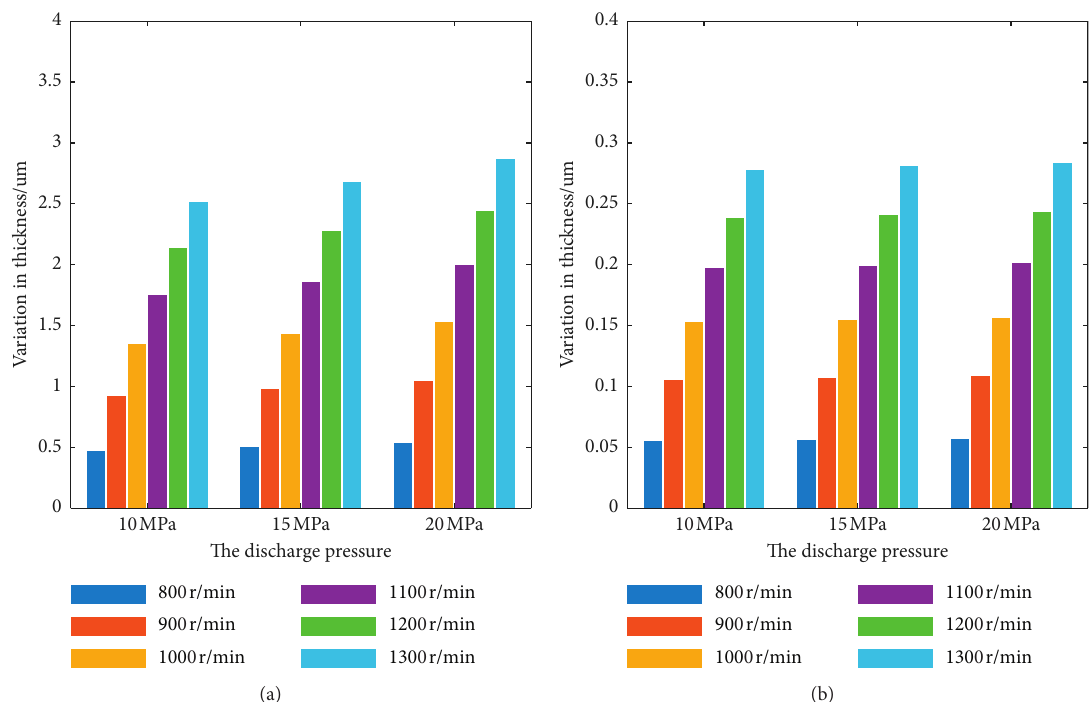
Figure 11: The variation of mean minimum film thickness. (a) The discharge region; (b) the suction region.